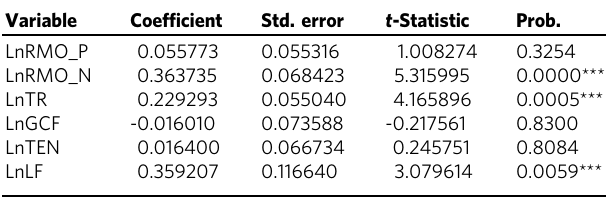
Table 5 Long-run relationship with lag variable. Table 4 Long-run level